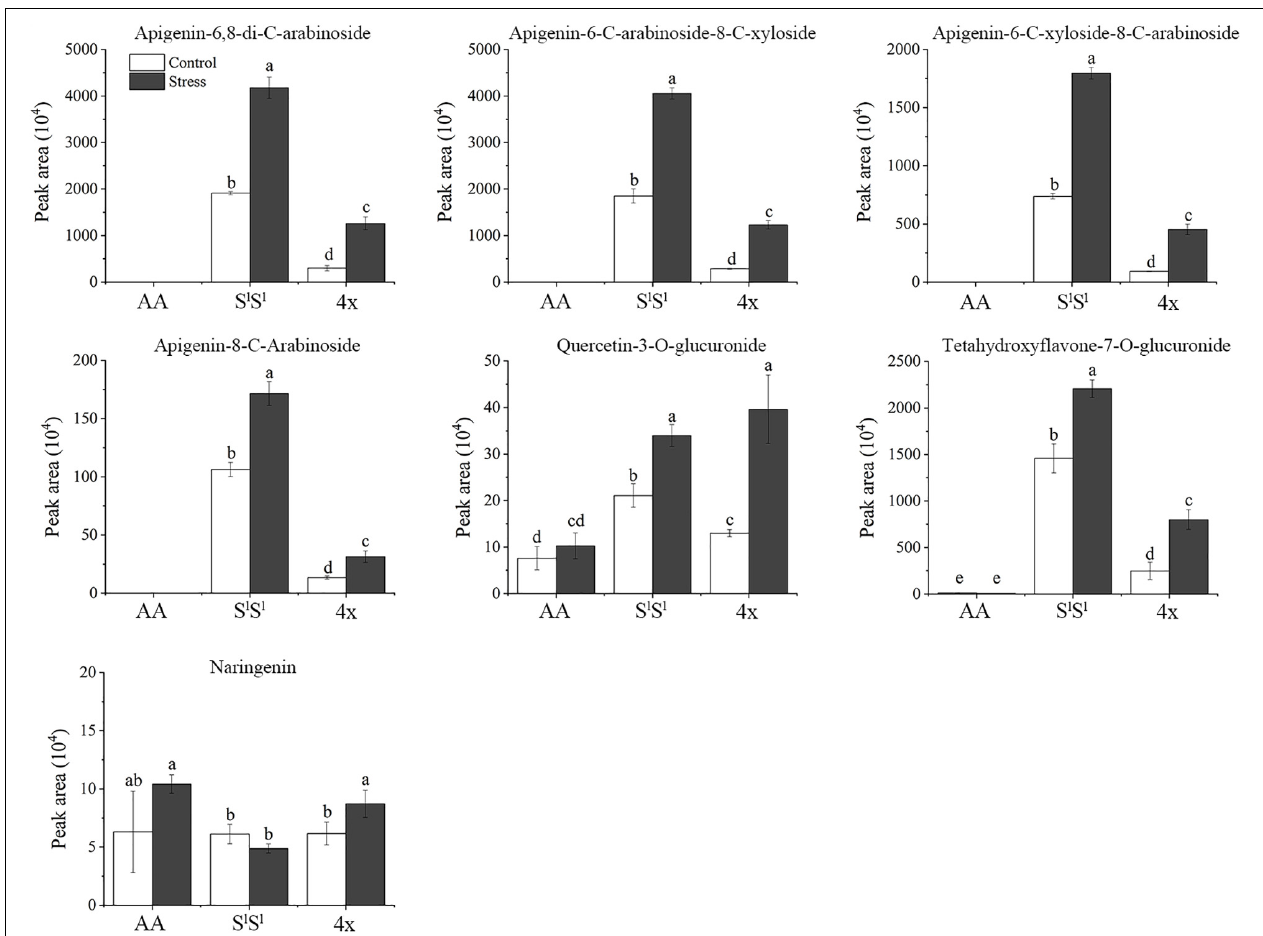
FIGURE 9 | Examples of flavonoids showing distinct salinity stress response of Triticum urartu plants and the synthetic tetraploid wheat and Aegilops longissima plants. The seedlings were exposed to 150 mM NaCl for 7 days. The values are the mean ( ± SD) of three biological replicates. Different letters above the bar showed significant differences among wheat lines and treatments according to t -test ( P <